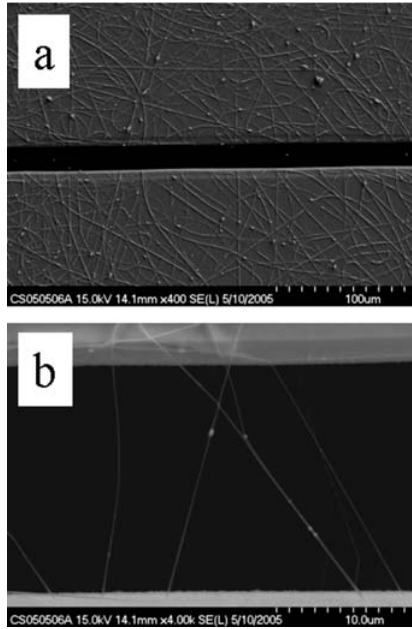
Figure 10. SEM image of noncalcined SnO